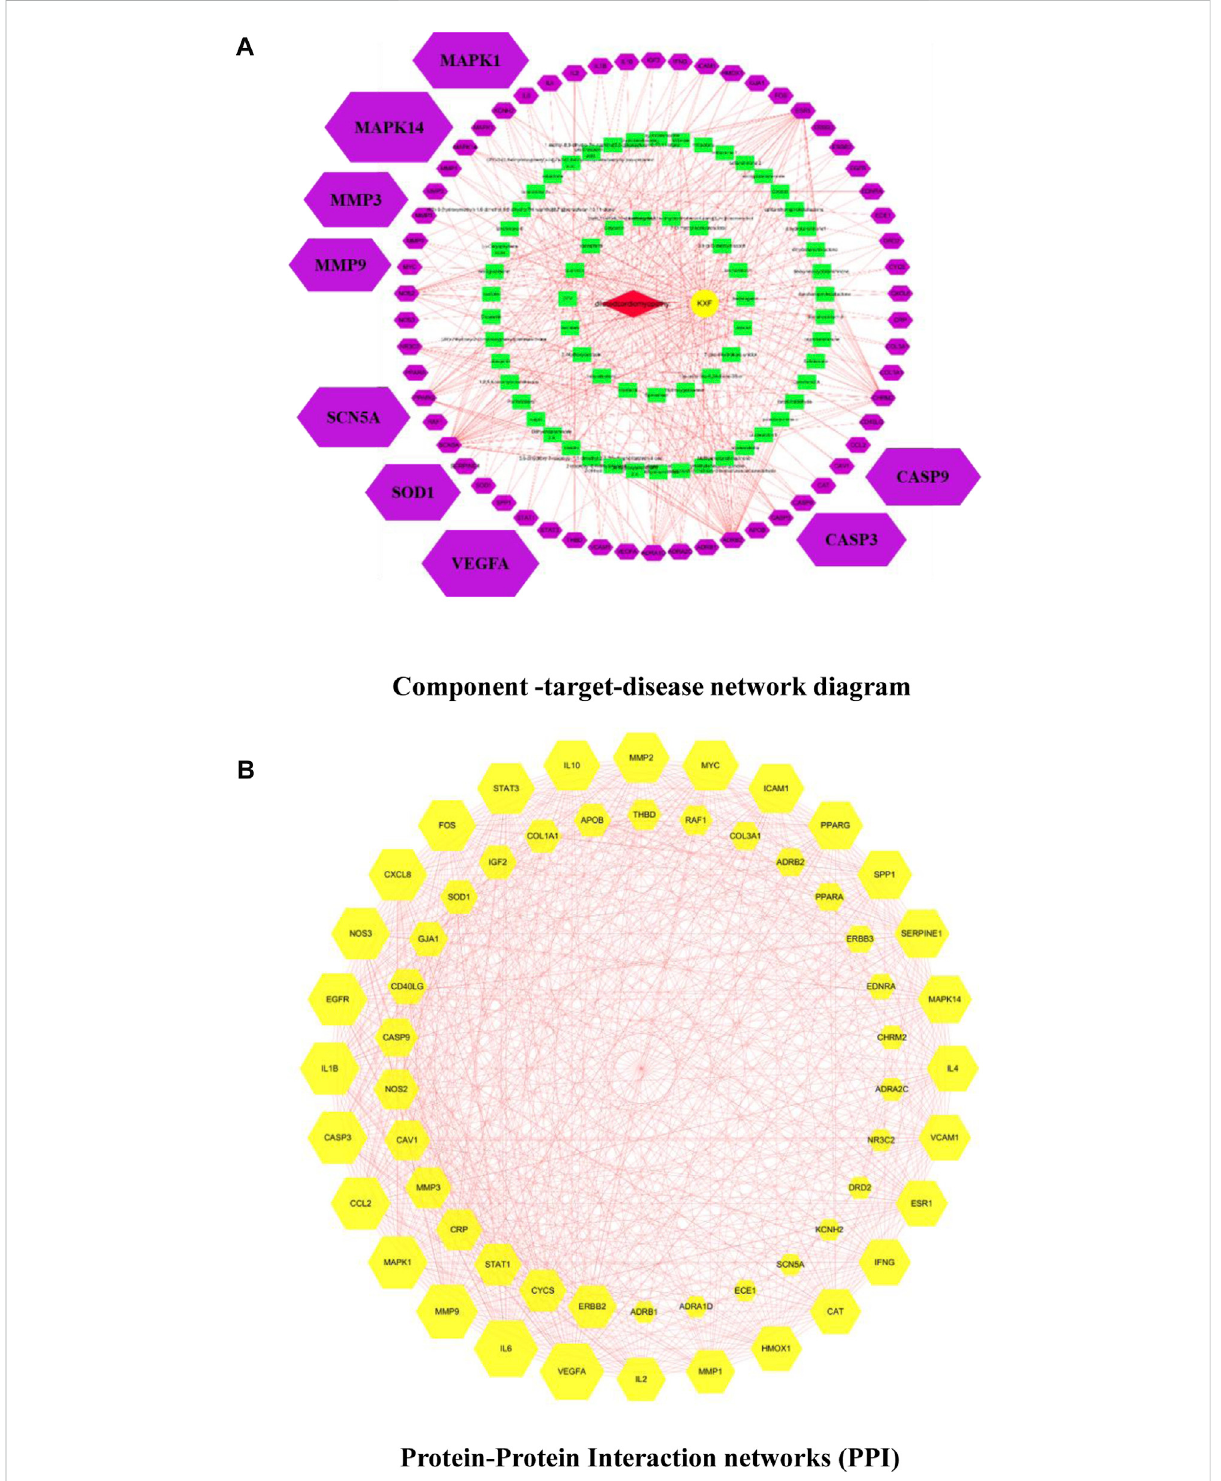
FIGURE 2 (A) .Component-target – diseasenetworkdiagram.Cross-referencestoKXFandDCMtargetstoidentifypotentialtargetsofKXFassociatedwith DCM. Red nodes represent DCM. The yellow node represents KXF. Green nodes represent the compounds in KXF. Purple nodes represent potential targetsofKXFofDCM. (B) .Protein – proteininteractionnetwork(PPI)showstheinteractionsbetweenoverlappinggenes.Theyellownoderepresents a gene, and the red line represents the interaction between genes. The larger the area covered by a gene, the more pronounced the effect of KXF has on that